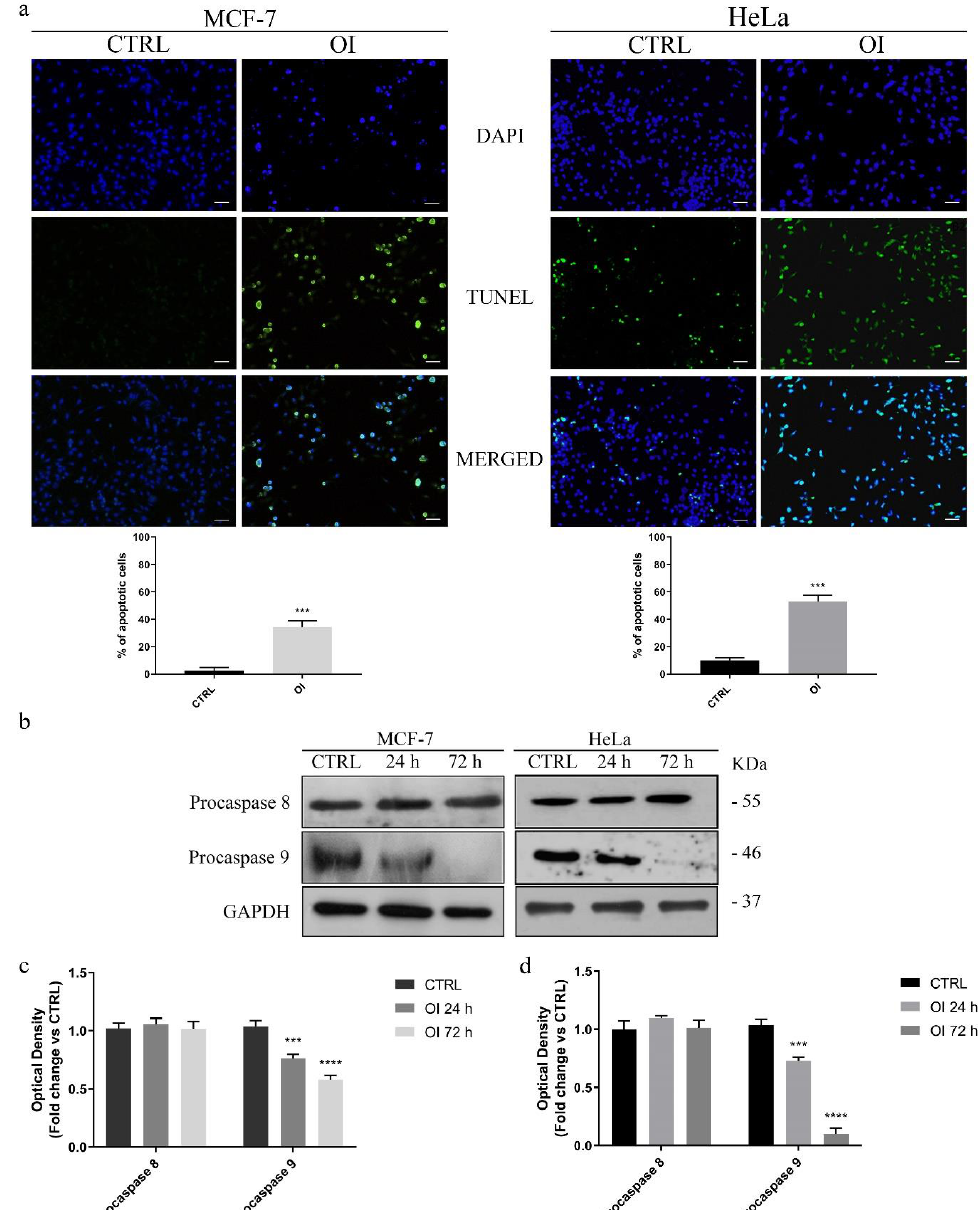
Figure 3. OI treatment triggers cell death by apoptosis. ( a ) TdT-mediated dUTP nick-end-labeling (TUNEL) assay in MCF-7 and HeLa cells treated for 72 h with DMSO (CTRL) or 15 and 30 µ M OI , respectively. DAPI was used to visualize the cell nucleus. Scale Bars 50 µ m. Histograms represent means ± SD of apoptotic cells from three independent experiments. ( b ) Immunoblot analysis of pro-caspases 8 and 9 after 24 and 72 h of OI treatment (see Materials and Methods, par. 2.6). GAPDH was used as a loading control. Densitometric quantification of pro-caspase expression levels in MCF-7 ( c ) and HeLa ( d ) treated cells vs. control cells. Remarkably, OI treatment induces apoptosis by activating the intrinsic caspase-dependent apoptotic pathways. Values are means ± SD of three di ff erent experiments. *** p value < 0.001; **** p value <